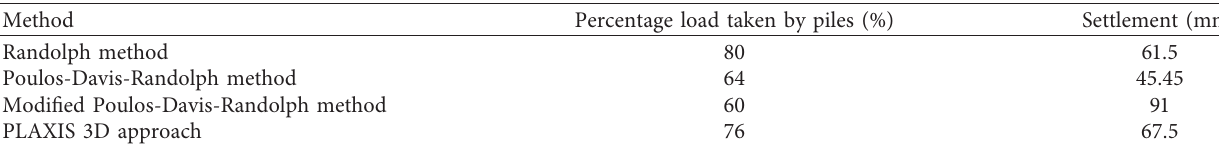
Table 5: Analysis results of 2nd case study. Percentage load taken by piles